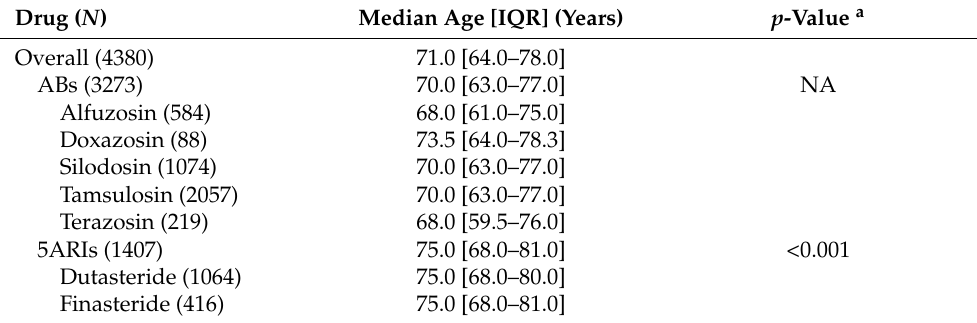
Table 3. Drugs prescribed and age of